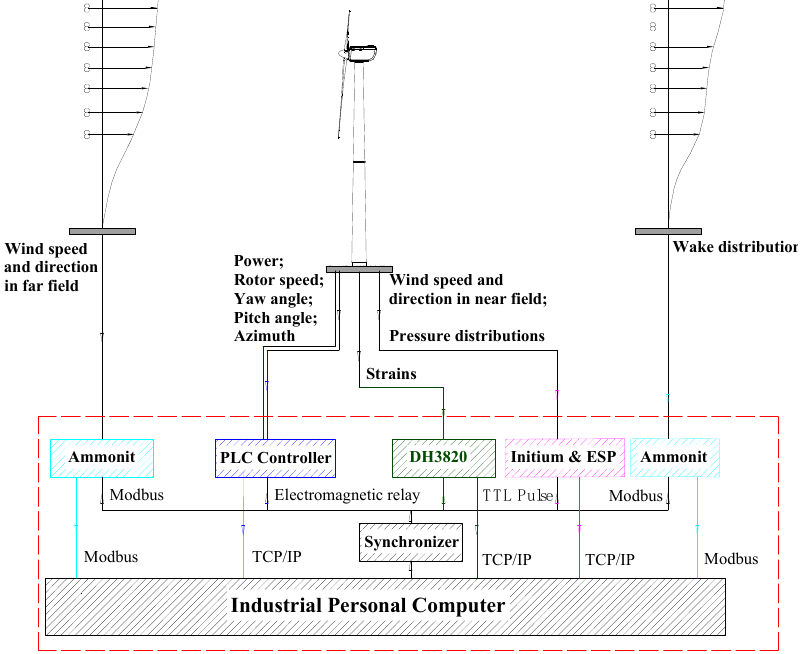
Figure 7. The measuring and controlling system.